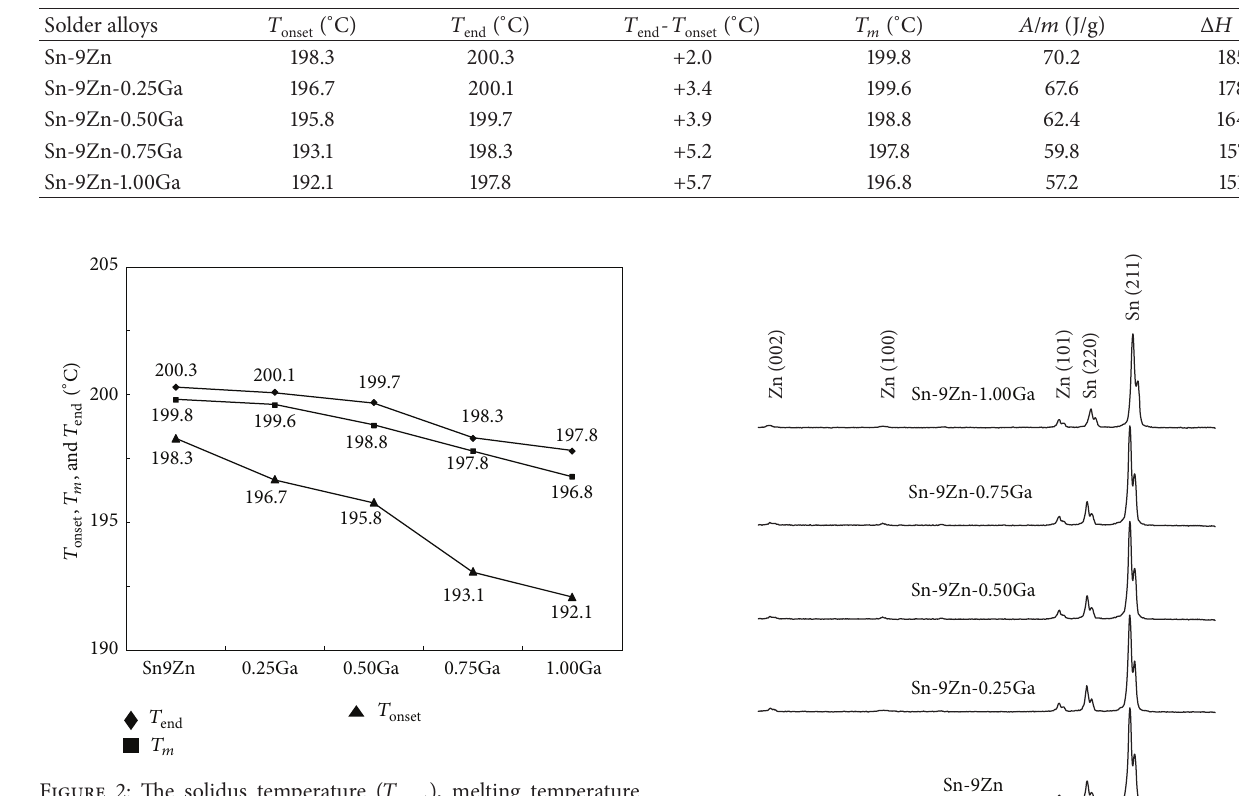
), liquidus temperature ( 𝑇 onset